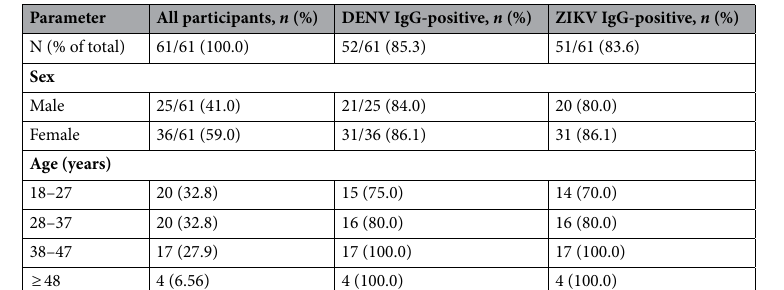
Table 1. Characteristics and DENV/ZIKV serostatus of